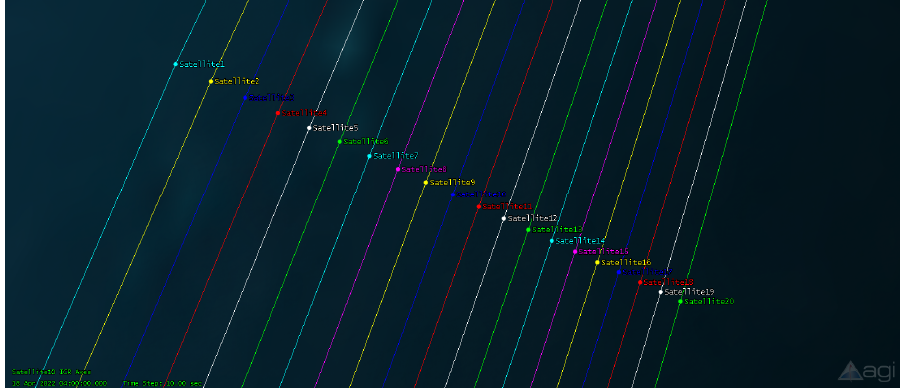
Figure 4. Tracks for SC1 to SC20 in the Satellite Tool Kit.